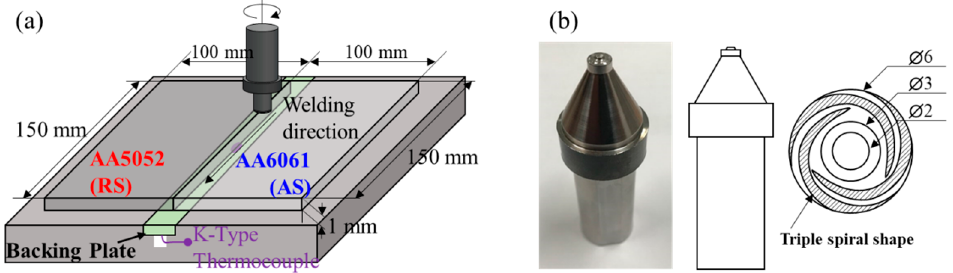
Figure 2. Schematic diagrams of ( a ) the overall micro-friction stir welding ( µ -FSW) setup and ( b ) the welding tool used in this study.